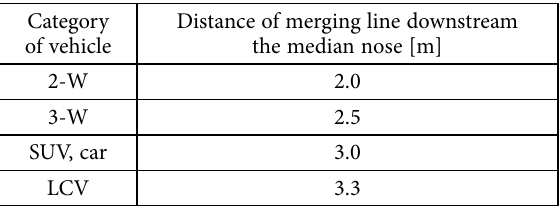
Fig. 9. Measurement of SD and MT in